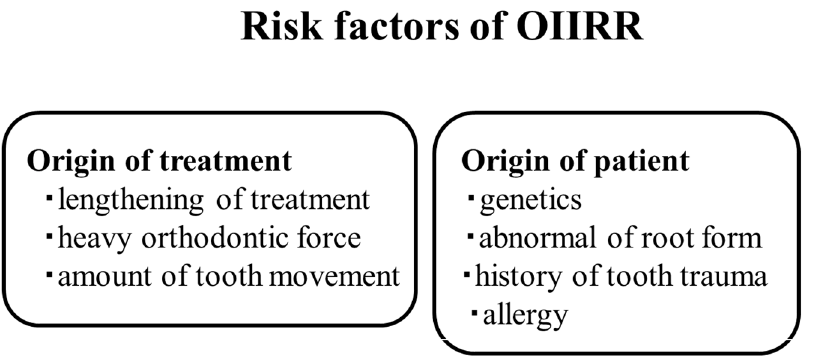
Figure 4. Risk factors of OIIRR.